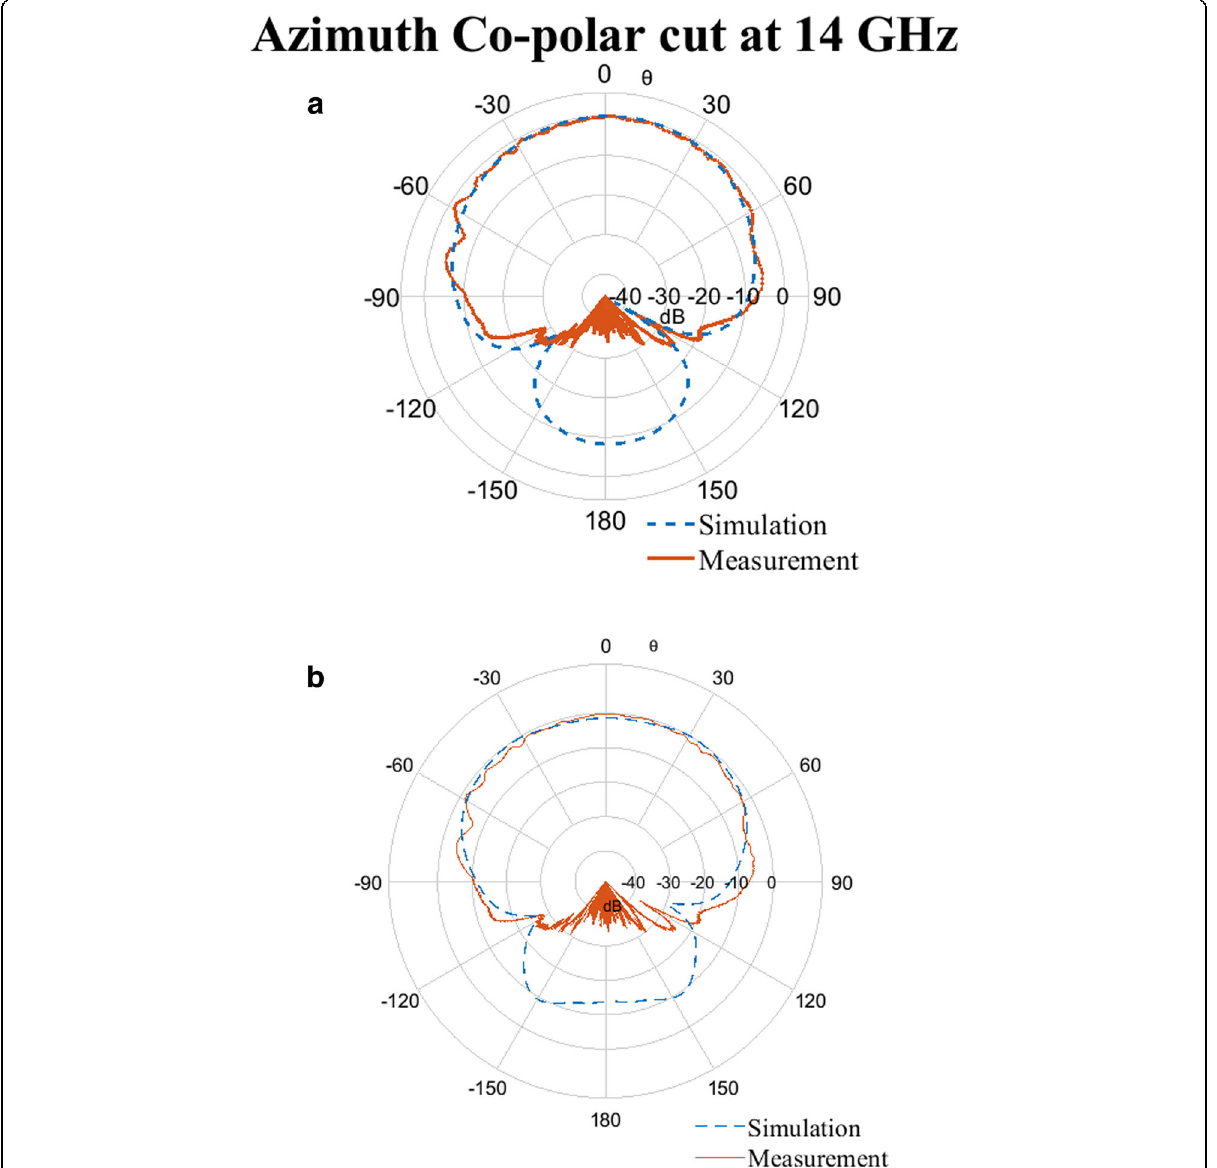
Fig. 25 Comparison of simulated and measured azimuth cut. a Simulation curve is without anechoic chamber backplate. b Simulation curve is with anechoic chamber